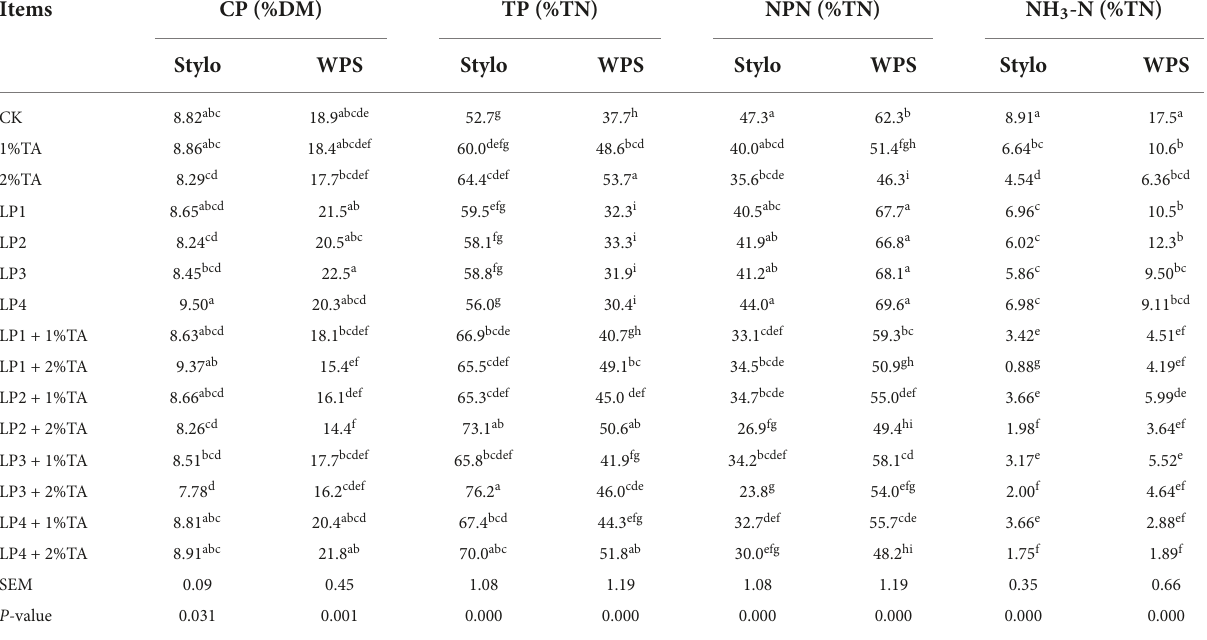
TABLE 4 Effects of the addition of lactic acid bacteria and tannic acid on the protein contents of silage of stylo and soybean.